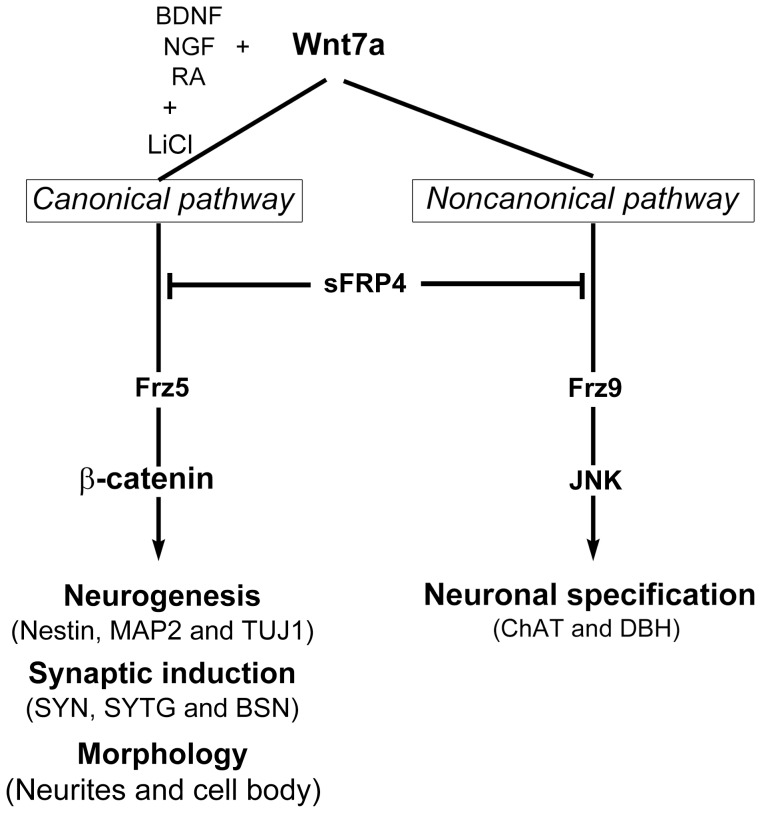
Summary of neuronal transdifferentiation regulation by Wnt7a in human bone marrow-derived MSCs.Accompanying NGF, BDNF, and RA, Wnt7a activated the canonical/β-catenin pathway via receptor Frz5 to promote neurogenesis and trigger synaptic marker (SYN1) expression. Furthermore, Wnt7a also triggered differentiations of cholinergic and dopaminergic neurons, but this effect was induced by another non-canonical/JNK pathway through Frz9 receptors. In this study, we showed that Wnt7a utilized two pathways to promote hMSC neurogenesis.